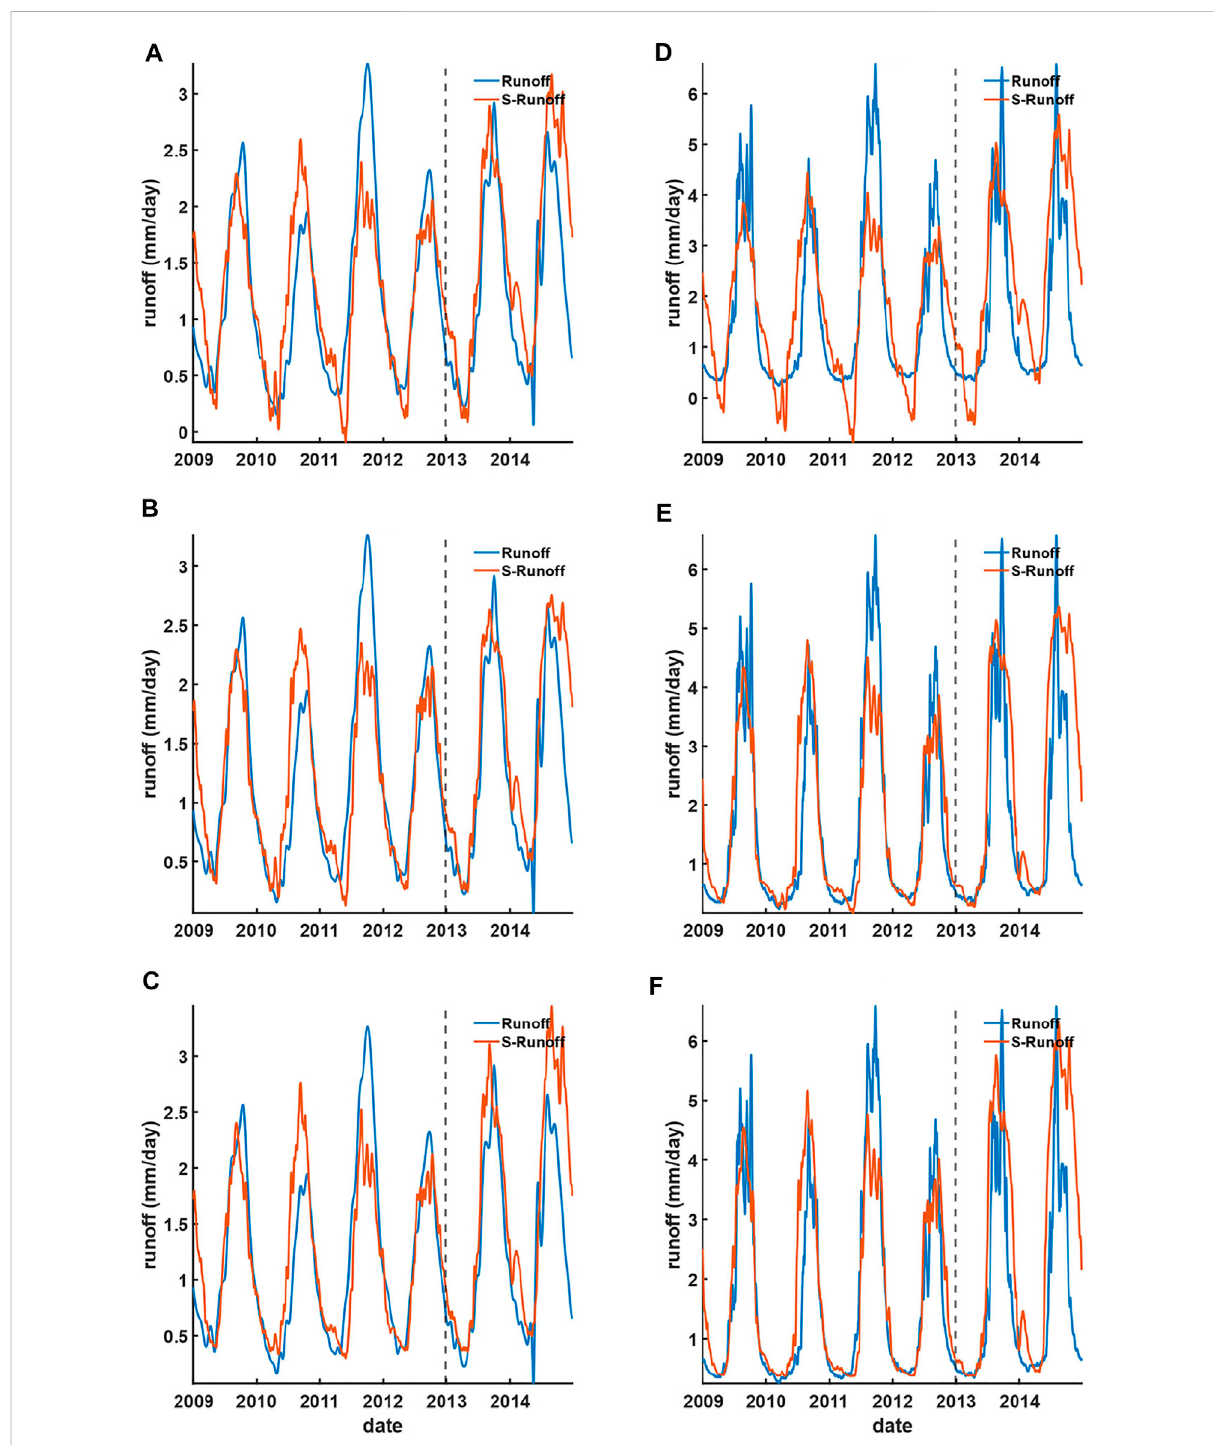
FIGURE 9 Reconstructed (during 2009 – 2012) and forecasted (during 2013 – 2014) runoff using the upstream GRACE water storage based on (A) linear regression, (B) ANN, and (C) LSTM models against the TC-CD station and (D) linear regression, (E) ANN, and (F) LSTM models against the Kratie